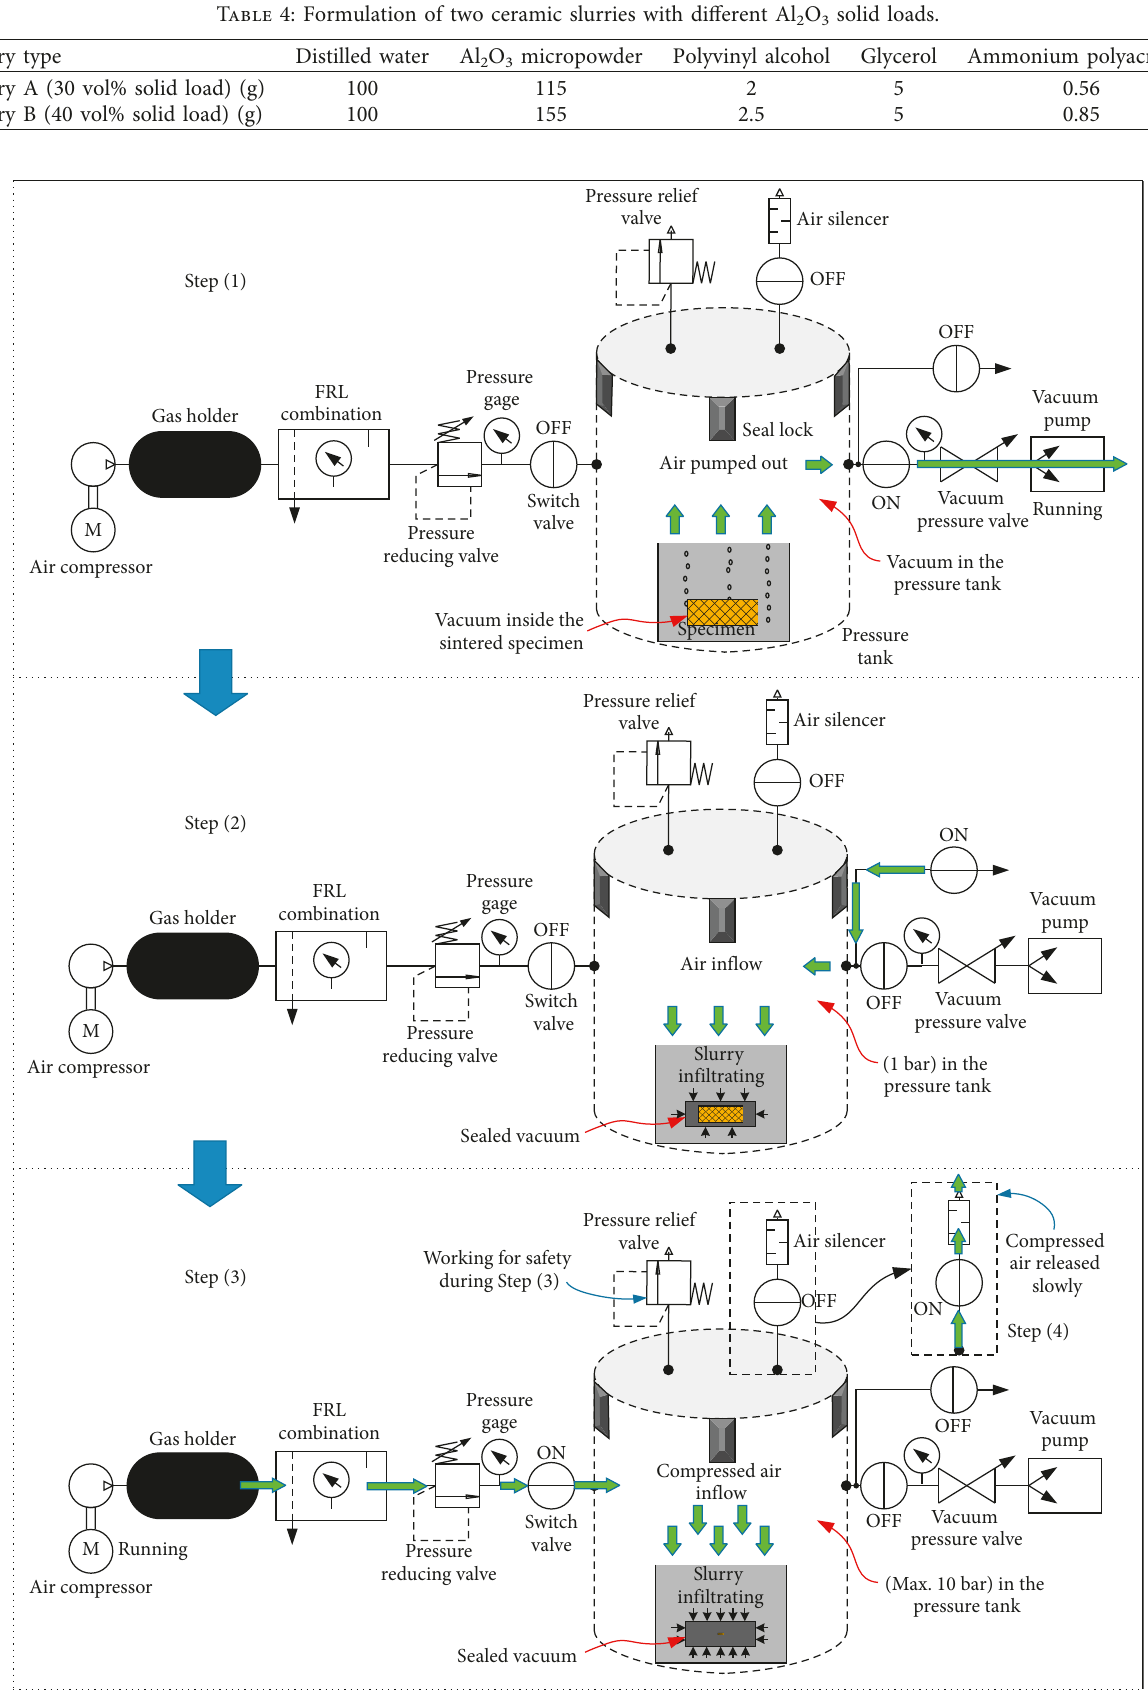
Figure 7: Home-made infiltration apparatus and related operations for two working